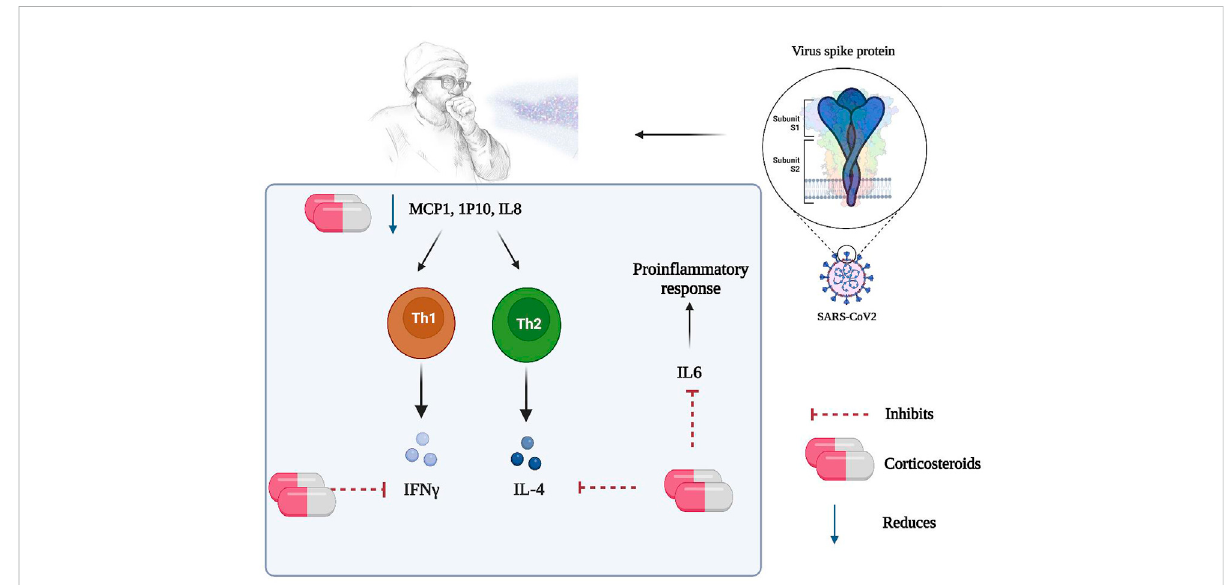
FIGURE 1 Possible mechanism of action of steroids in the management of COVID-19.